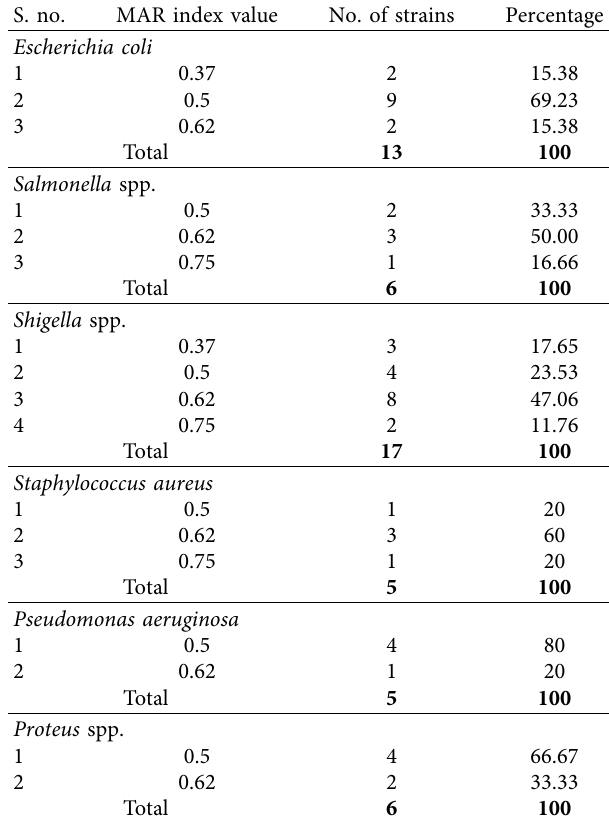
Table 7: Multiple antibiotic-resistant (MAR) index values of re- sistant